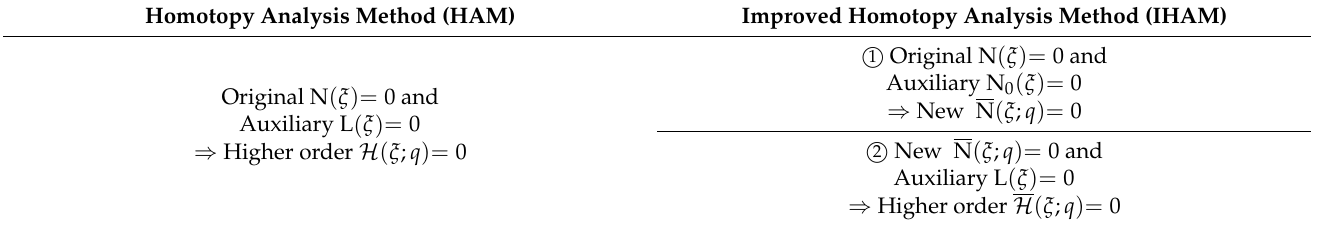
Table 1. Comparison of improved homotopy analysis method against homotopy analysis